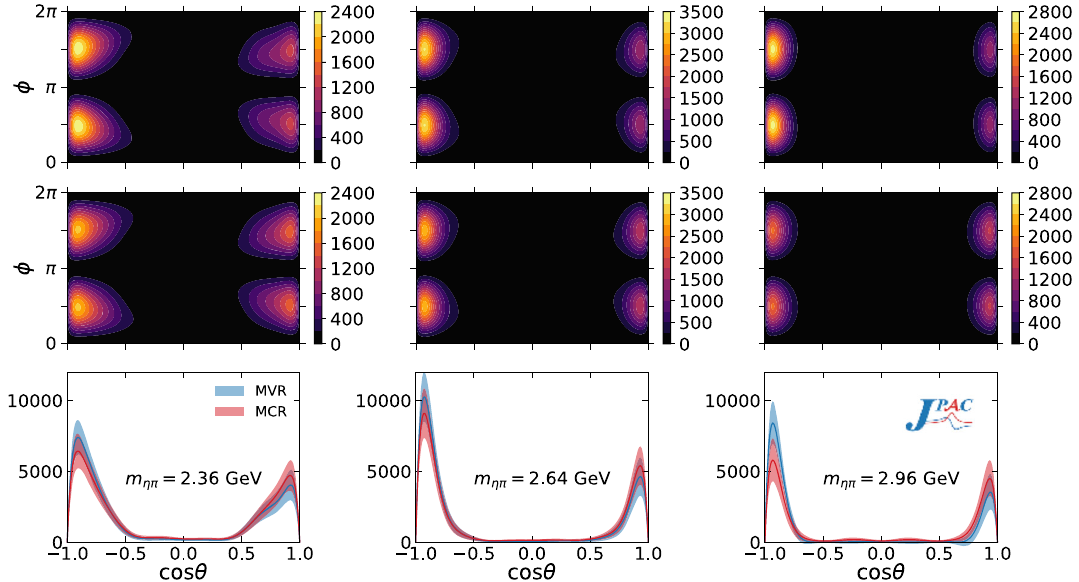
Fig. 1 cos θ vs. φ expected value intensity I ( m ηπ ,(cid:4)) density plot for MVR (upper) and MCR (center) of the COMPASS partial waves of the ηπ channel for three fixed energies ( m ηπ = 2 . 36, 2 . 64, and 2 . 96GeV). The lower row provides the φ -integrated I θ ( m ηπ , cos θ) MVR